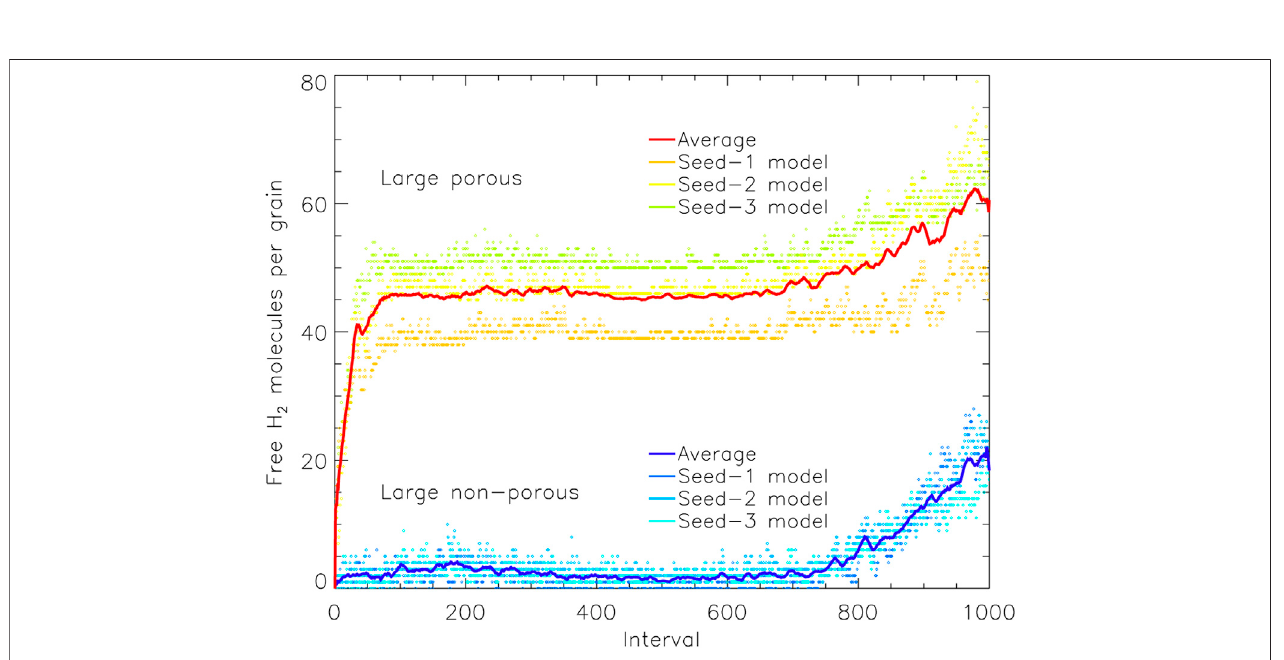
FIGURE 6 | The amount of free molecular hydrogen present on the grain plotted vs. relative time interval, for the large porous and non-porous grain models. Free species are able to undergo surface diffusion and desorption, but may reside on enclosed surfaces within pores. The solid lines show a moving average (of period 10)